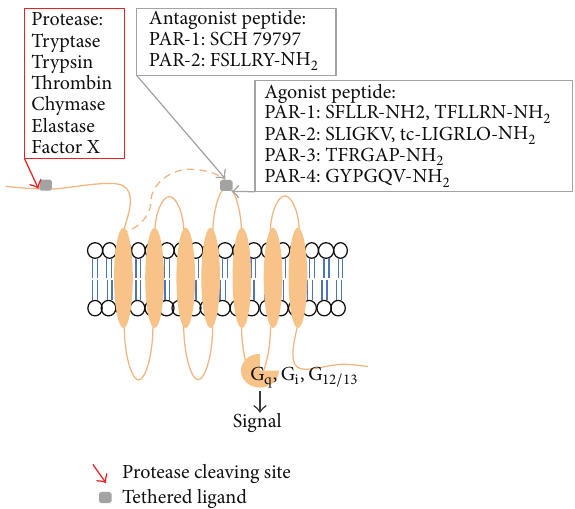
Figure 1: Activation mechanism of protease activated receptor (PAR). PARs are a group of four G protein-coupled receptors (GPCRs). Activation of PARs depends on the protease cleavage at the specific site of the extracellular N-terminal, upon which the exposed tethered ligand (gray square) binds to the second extracellular loop of PAR resulting in a series of cellular signaling events. The red arrow indicates cleavage site. The site for PAR-1 is at LDPR41 ↓ S42FLLRN, PAR-2 is at SKGR34 ↓ S35SLIGKV, PAR-3 is at LPIK38 ↓ T39FRGAP, and PAR-4 is at PAPR47 ↓ G48 YPGQV. PAR-2 antagonist peptide: FSLLRY-NH 2 ; SCH 79797: a PAR-1 antagonist; the active peptides were PAR-1: SFLLR-NH 2 , TFLLRN-NH 2 ; PAR- 2: SLIGKV-NH 2 , transcinnamoyl- (tc-) LIGRLO-NH 2 ; and PAR-3: TFRGAP-NH 2 PAR-4, GYPGQV-NH 2 . S = Ser, F = Phe, L = Leu, R = Arg, T = Thr, I = Ile, G = Gly, K = Lys, V = Val, O = Pyl, A = Ala, P = Pro, Y = Tyr, Q = Gln, and V =